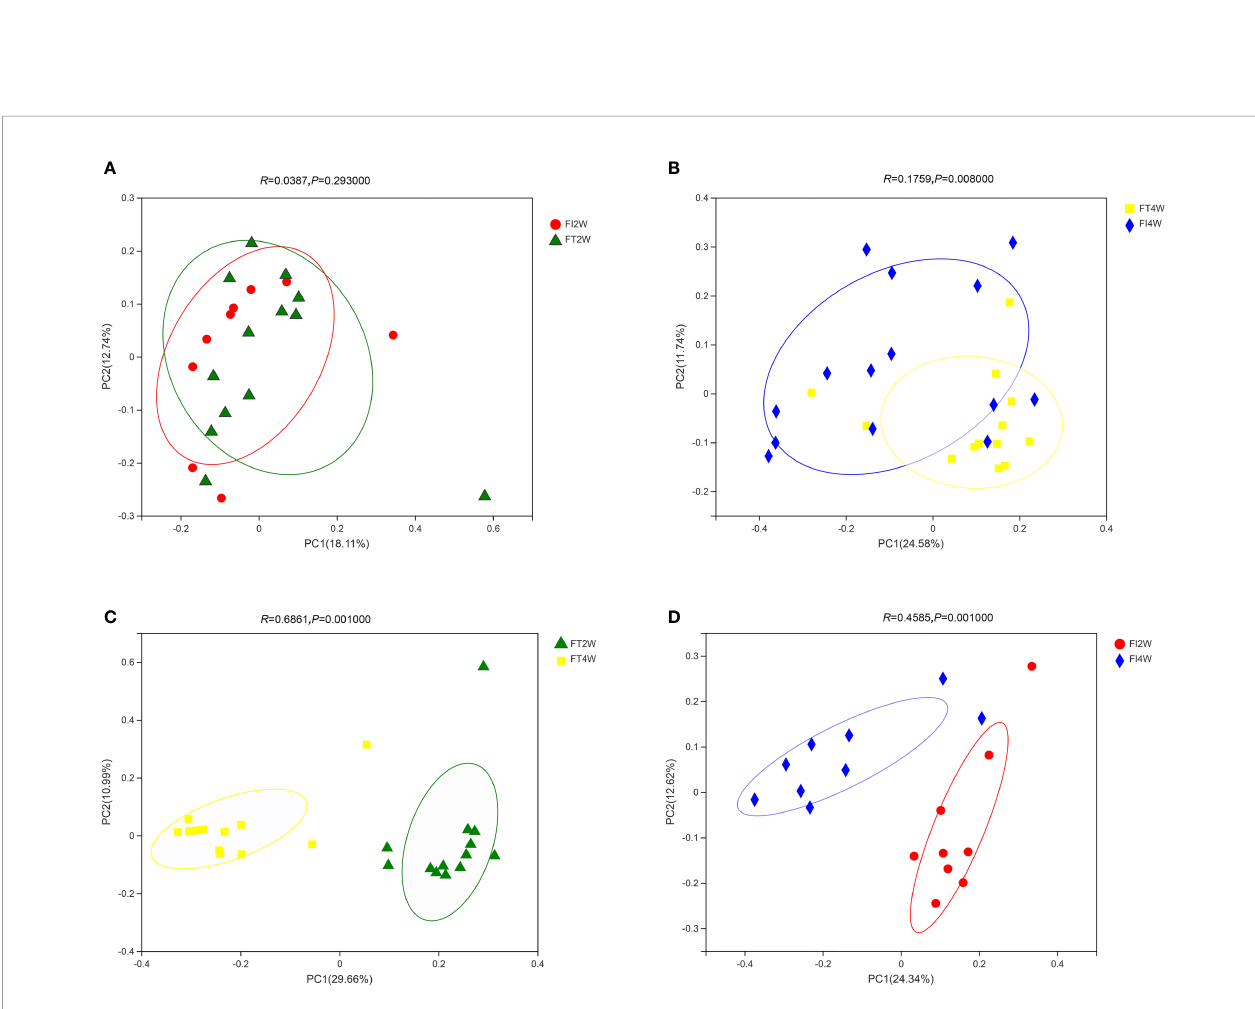
FIGURE 2 | Beta diversity of the microbiota in the different groups. There was no difference in beta diversity between the two groups at 2 weeks (A) , but there was a signi fi cant difference between the two groups at 4 weeks ( P <0.05) (B) . The beta diversity of the microbiota at 4 weeks was signi fi cantly different from that at 2 weeks in the FT (C) and FI groups (D) .